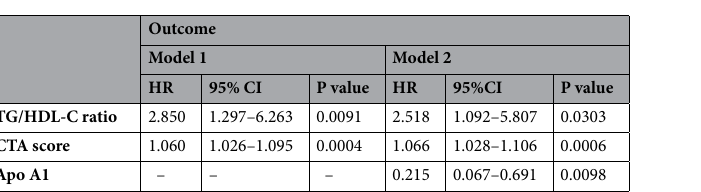
Table 4. Association of TG/HDL (IVQ) with the composite outcome end-point at multivariable Cox